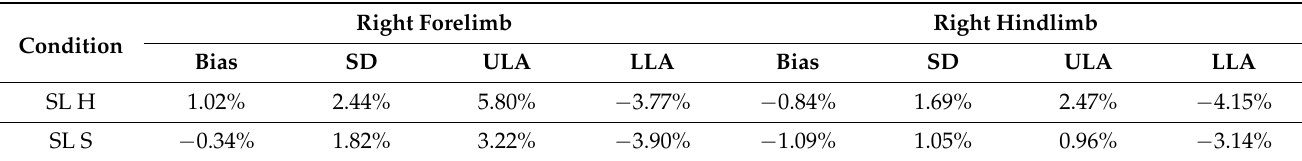
Table 4. Bland–Altman comparison (in percentage of stride duration%) of the reference stance duration and stance duration obtained with the developed method from the cannon bone data. Accuracy (bias), precision (SD), and upper/lower limits of agreement (ULA and LLA) were indicated for each condition: straight line (SL), left circle (LC), and right circle (RC), for both ground conditions— hard (H) and soft (S)—and for the right forelimb and right hindlimb. For the left-circle condition, the equipped limb was the one outside the circle. For the right-circle condition, the equipped limb was the one inside the circle. Results are in percentage of